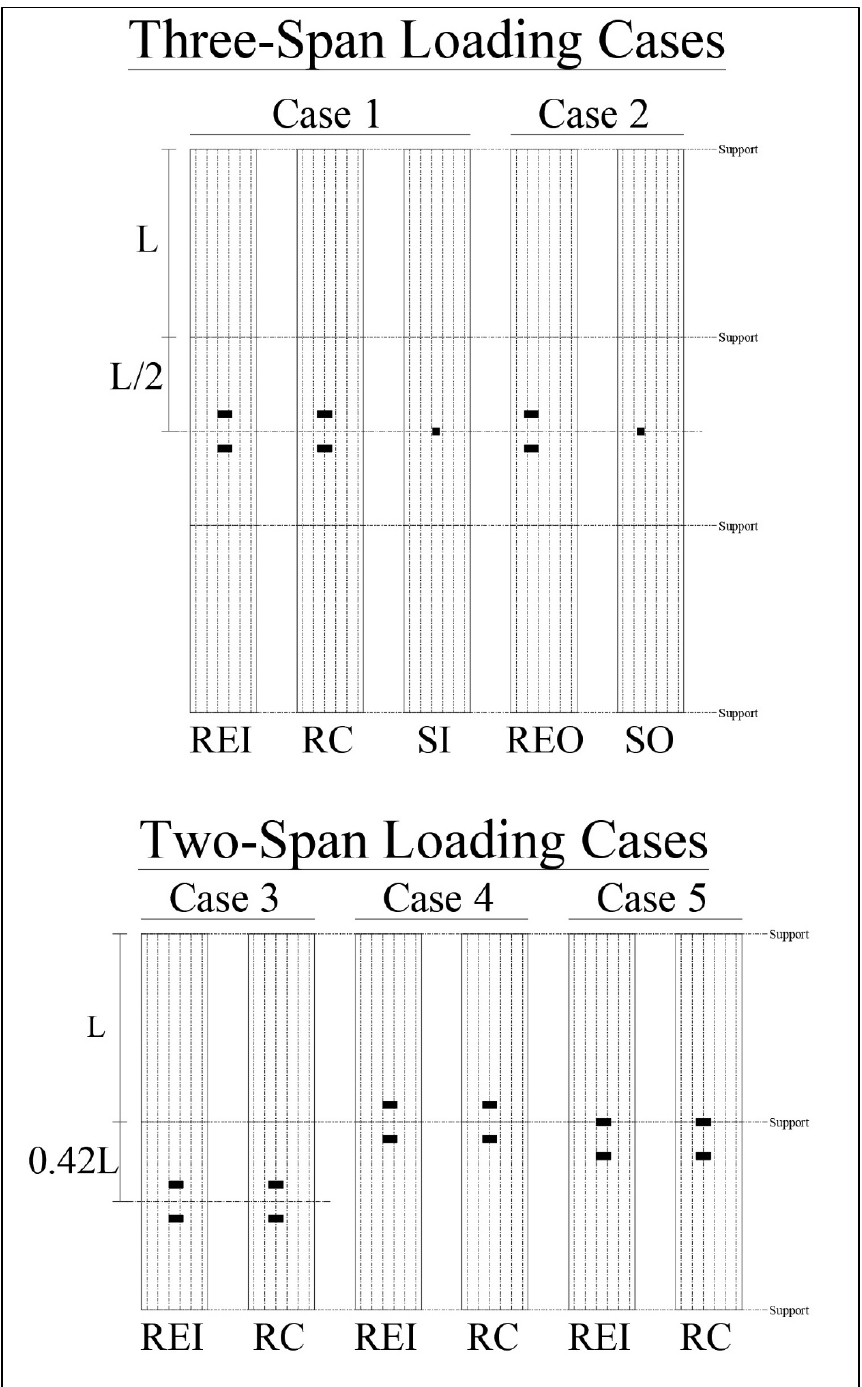
Figure 10. Three-dimensional continuum simulation load cases.